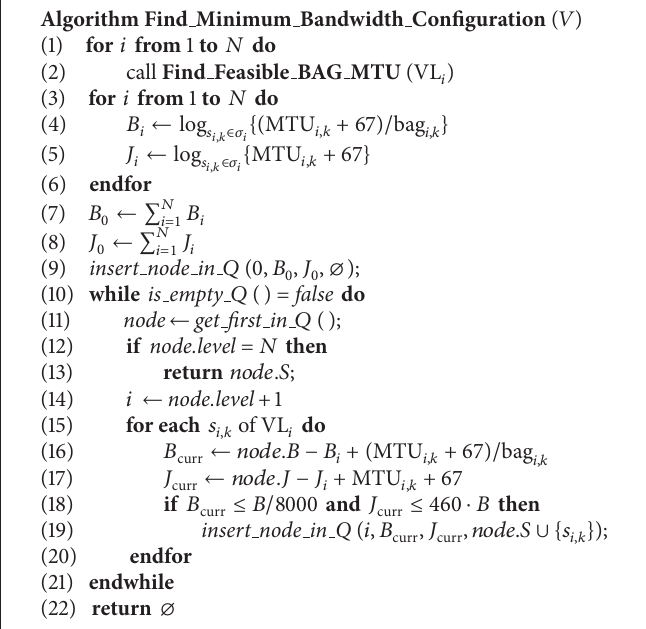
Algorithm Find Minimum Bandwidth Configuration ( 𝑉 )